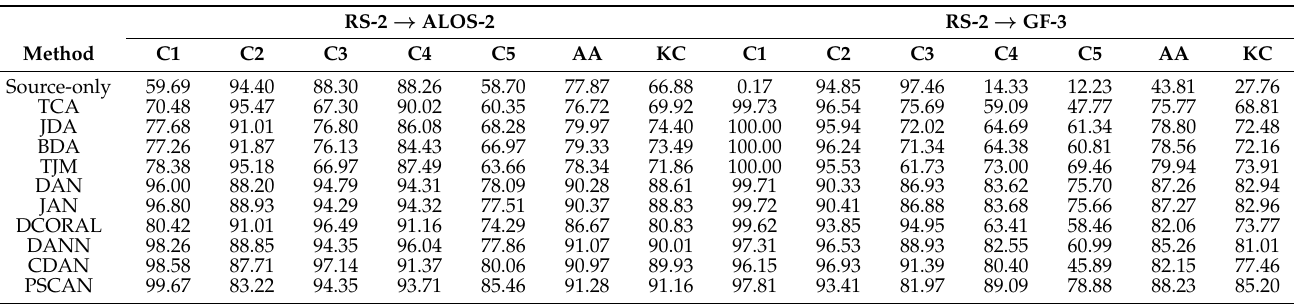
Table 4. Comparison of experimental results (%) on the San Francisco area when the source domain is set to RS-2.